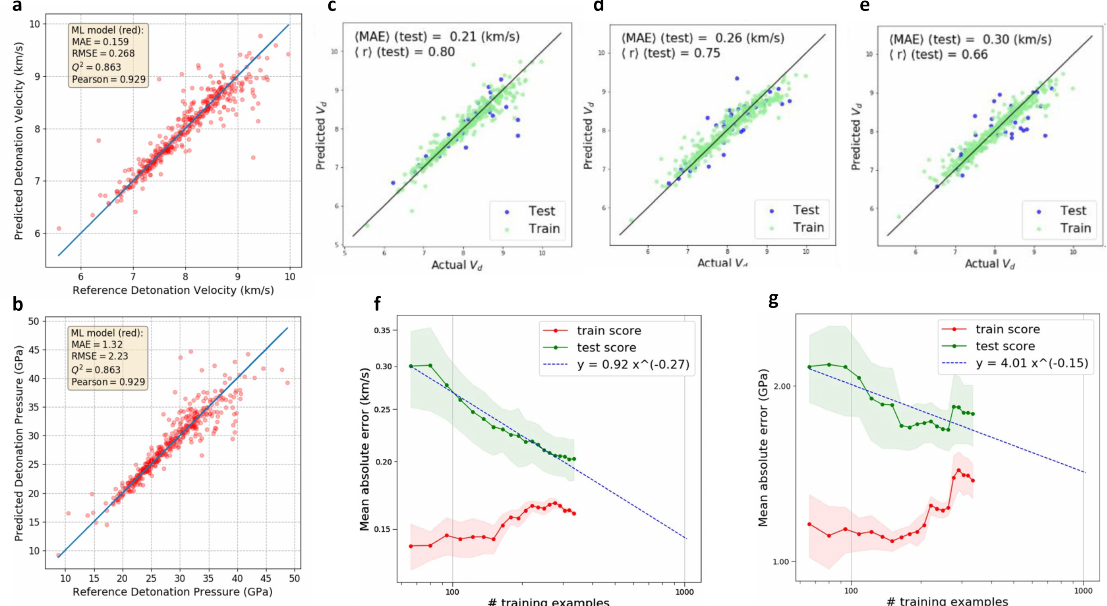
Figure 5. Detonation property prediction of energetic materials. ( a , b ) The performance of the neural network model for prediction of detonation velocity and pressure; ( c – e ) prediction accuracy of LASSO, Gaussian process regression (GPR), and neural network (NN), respectively; ( f , g ) left: learning curves of ML model for detonation energy; right: detonation pressure. ( a – e ) are adapted from Reference [94] with permission. ( f , g ) are adapted from Reference [91] with permission, copyright 2018 Springer